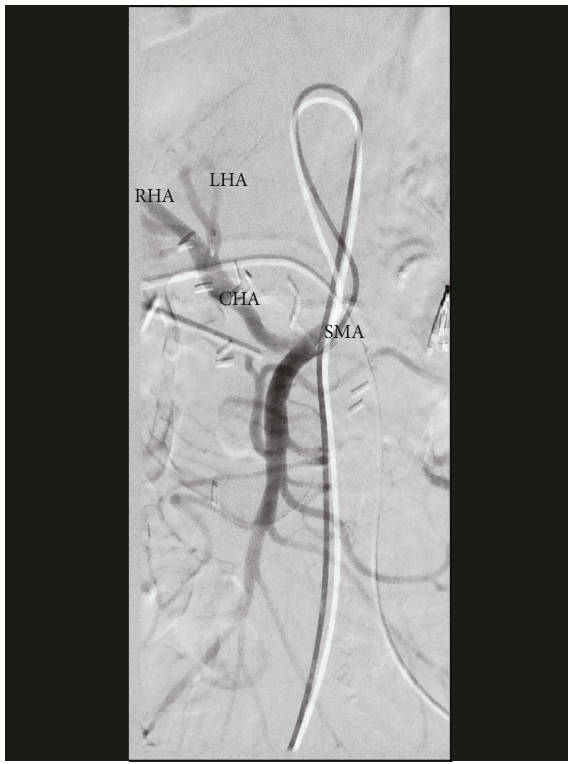
Figure 5: Fluoroscopic images during selective mesenteric angi- ography showing the common hepatic artery (CHA) arising from the superior mesenteric artery (SMA) and then bifurcating into the left (LHA) and right (RHA) hepatic arteries.